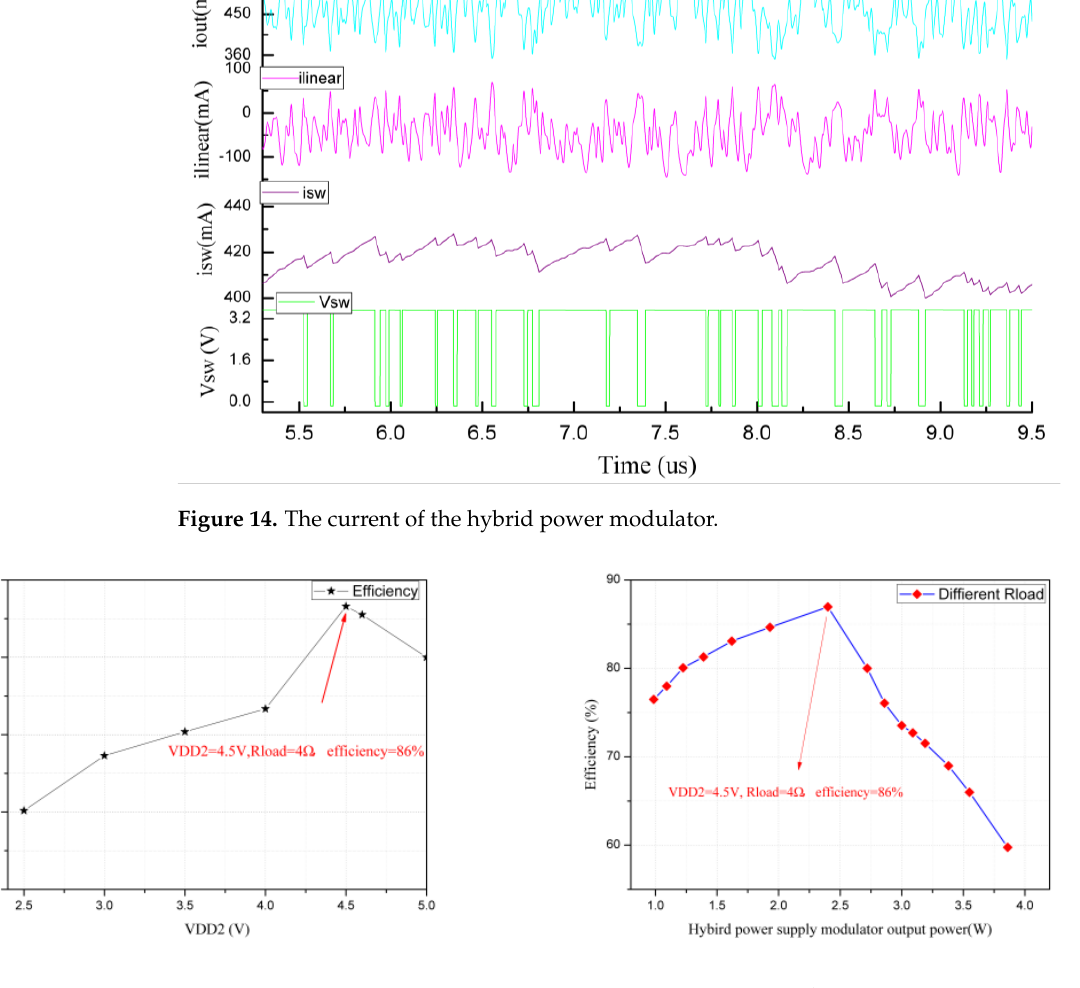
Figure 15. Influence of ( a ) different VDD2 and ( b ) different Rload on the output efficiency.